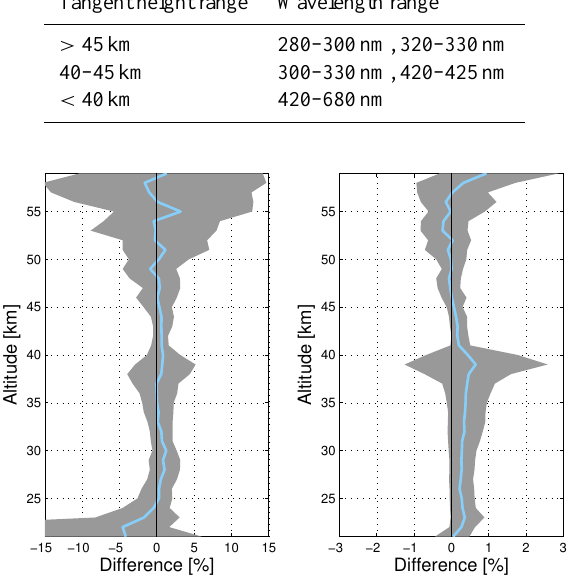
Figure 2. Sensitivity of GBL ozone profile to CCD band (left) and stray light correction method (right). Shown are the mean (solid line) and standard deviation (shaded area) of the relative individ- ual differences of the retrieved profiles in both cases. See text for